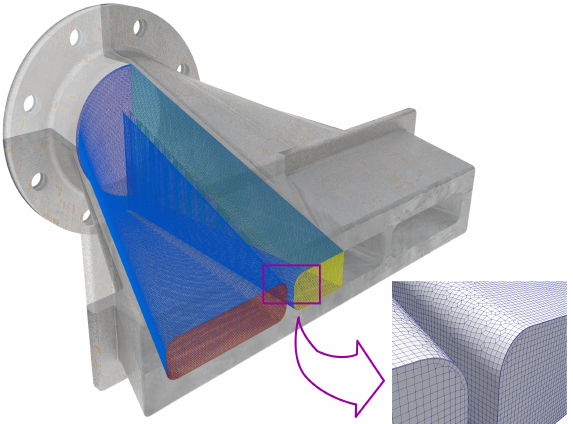
Figure 2. Visualization of investigated nozzle with numerical mesh